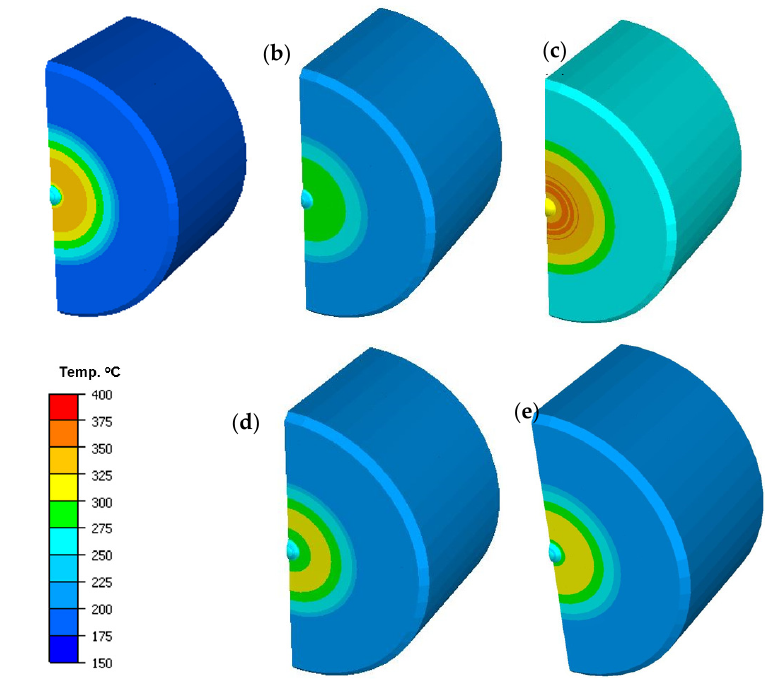
Figure 16. Temperature distributions on a punch’s section (for the half model from the axisymmetric system) for the selected process variants: ( a ) I nominal variant, ( b ) II, ( c ) III, ( d ) IV, ( e ) V.